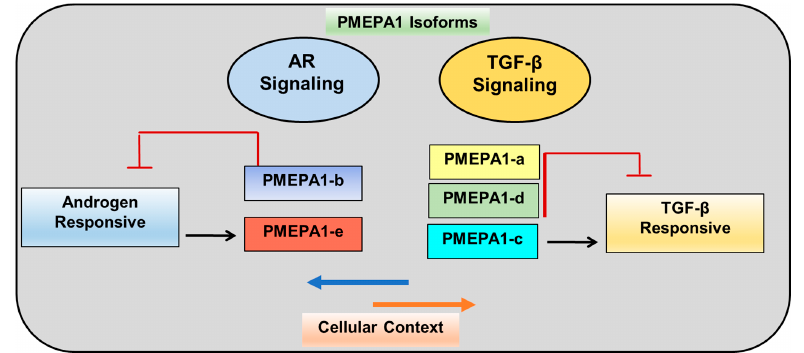
Figure 5. Navigation of distinct cellular signaling pathways by distinct PMEPA1 isoform in prostate cancer context.